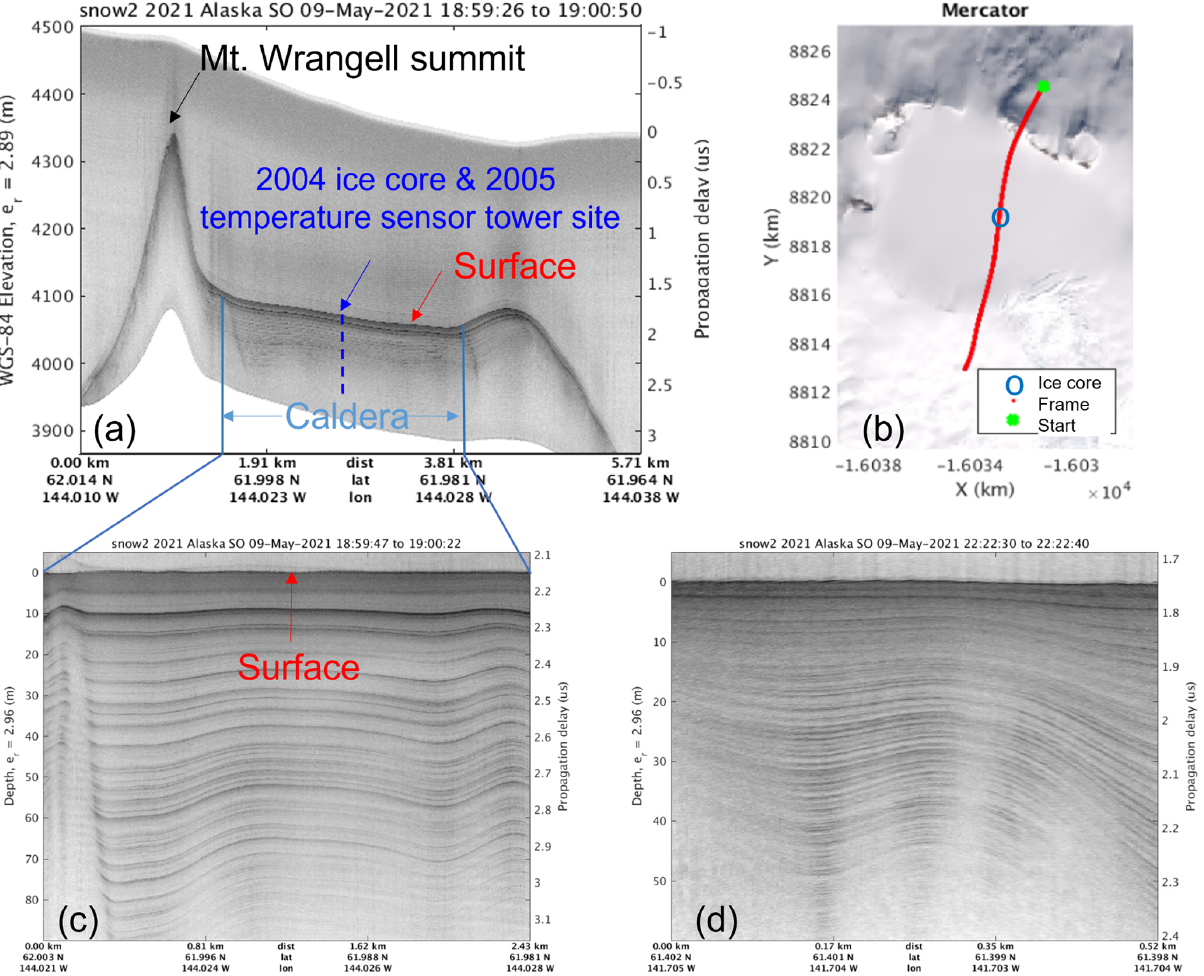
Figure 5. Conformable snow layers observed at mountain summit areas. (a) Mount Wrangell (WR); data collected on 9 May 2021. (b) The flight line in red marks the geolocations of the echogram in (a) on the Landsat image map. (c) Accumulation layers in the Caldera; and (d) Bona–Churchill (BO) – data collected on 9 May 2021; its location, marked by the green star in Fig. 4b, is close to the 2002 BC1 ice core drilling site. The snow surface profiles in (c) and (d) are both flattened in order to better display the